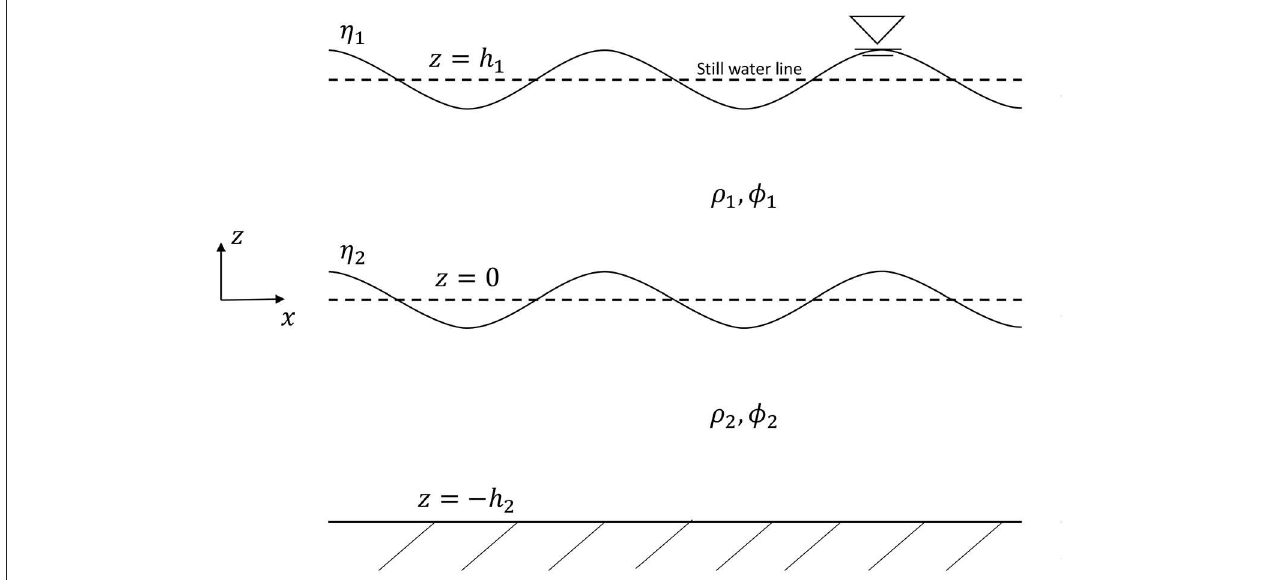
FIGURE 2 | Schematic of the Boundary Value Problem for a two-layer stratified internal wave.